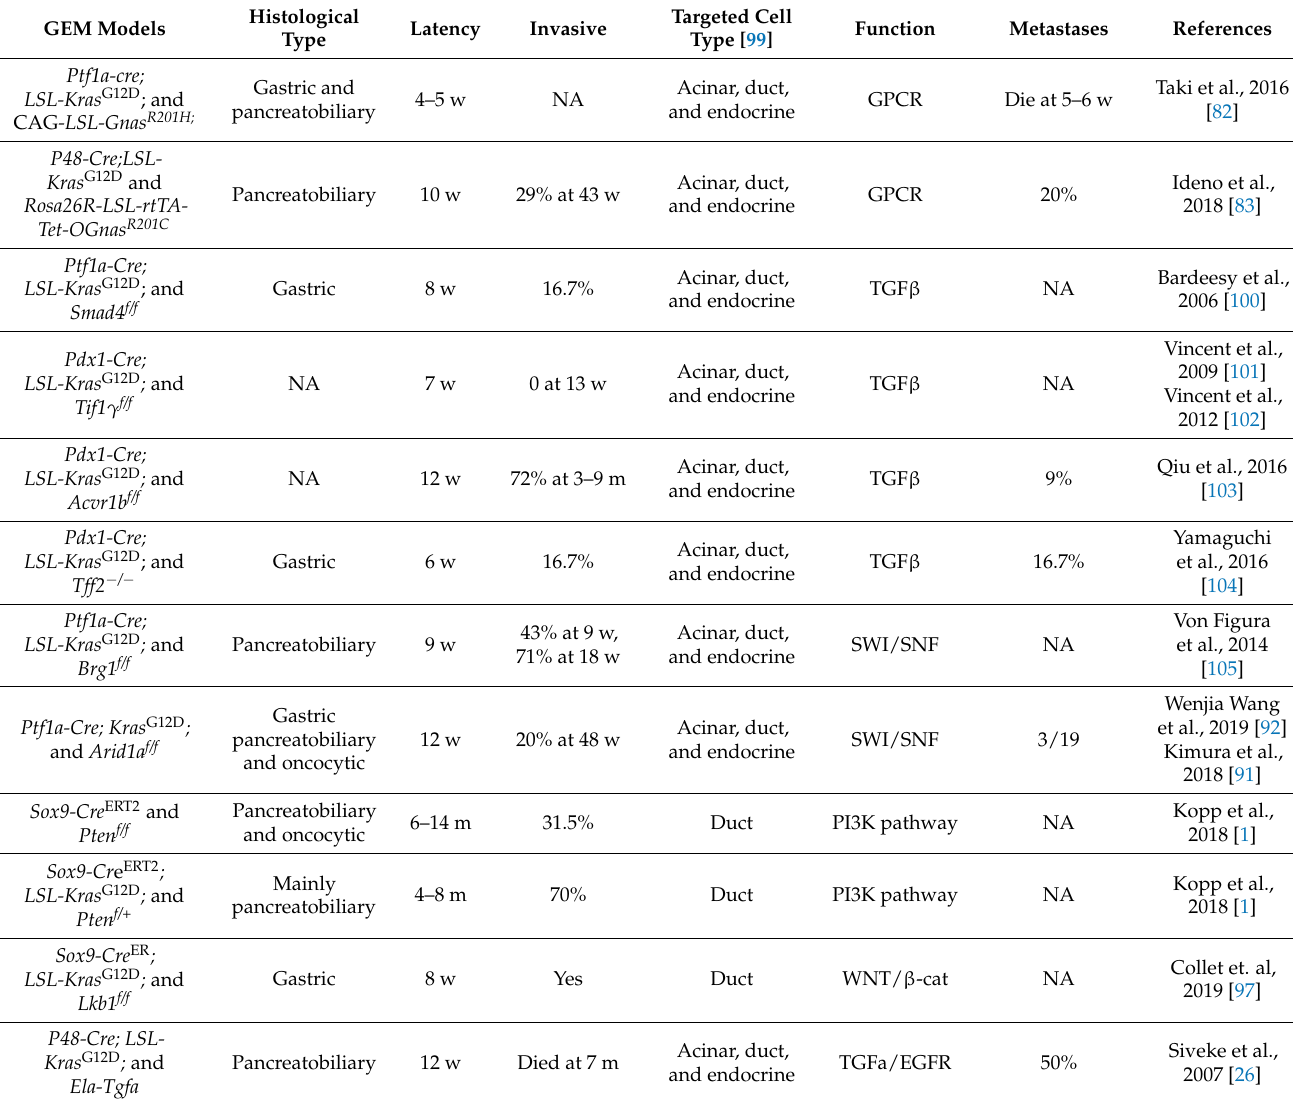
Table 2. Genetically engineered mouse models of